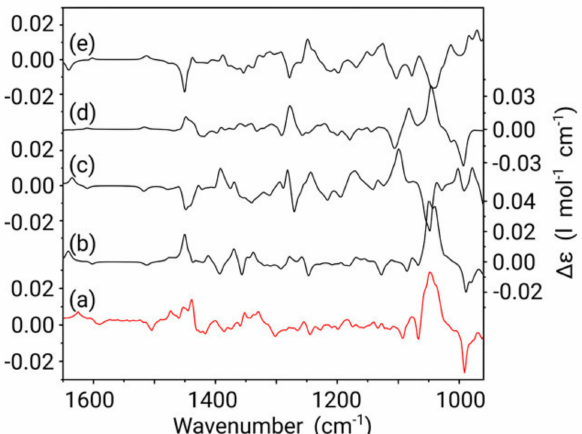
Figure 11. Comparison between the experimental VCD spectrum (measured in CDCl 3 ) of galan- tamine ( a ) and Boltzmann weighted calculated VCD spectra of the 4a S ,6 R ,8a S ( b ), 4a S ,6 R ,8a R ( c ), 4a R ,6 R ,8a S ( d ) and 4a R ,6 R ,8a R ( e ) configurations of the molecule. Y -axis labels are placed alternating left/right to avoid congestion. Reprinted with permission from ref. [51]. Copyright 2019 American Chemical Society.